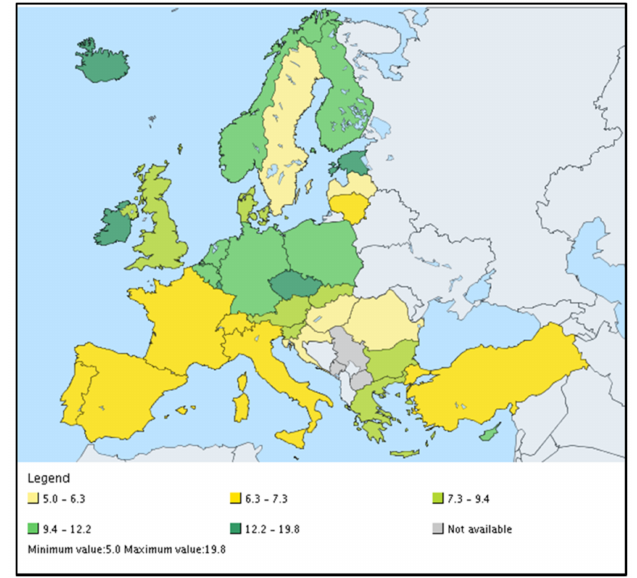
Figure 1. Greenhouse gas emission per capita in EU-28. Mg of CO 2 equivalent per capita—2016